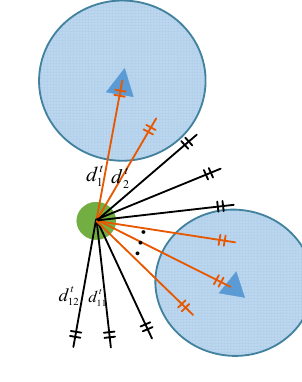
Figure 2. Distance diagram in the environment.